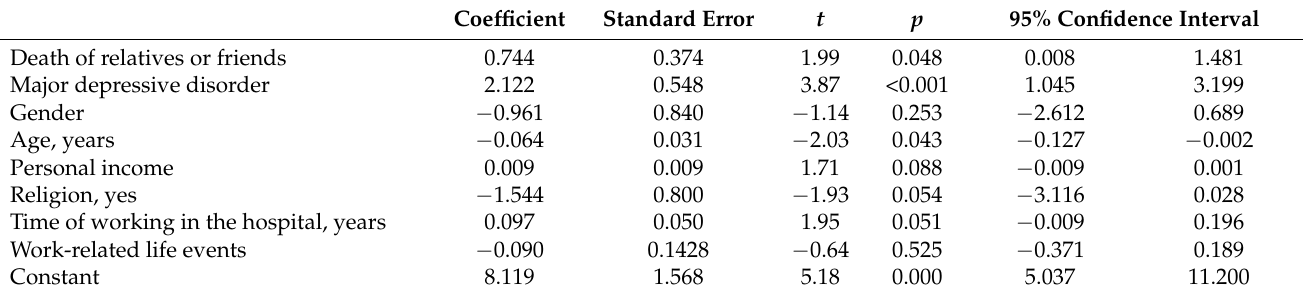
Table 5. Influence of life events of death of relatives or friends on depersonalization: Multiple linear regression analysis adjusted for